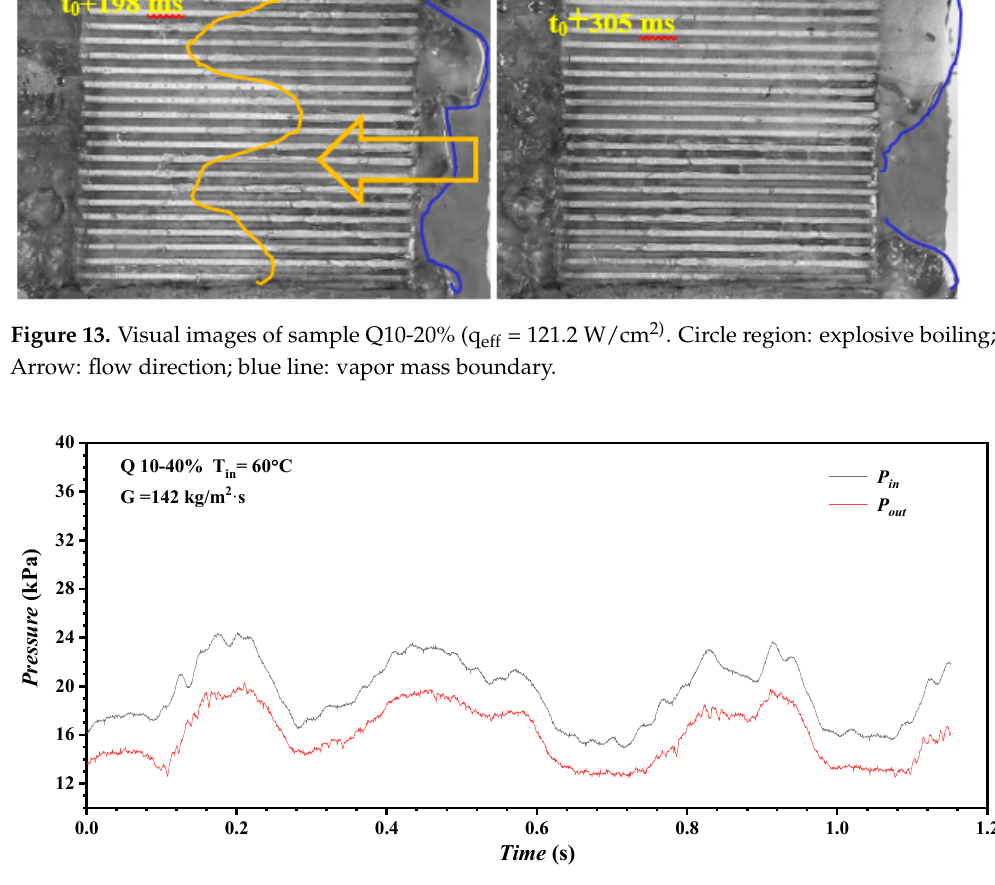
Figure 14. Pressure fluctuation curve of sample Q10-40% (q eff = 121.2 W/cm 2 ).